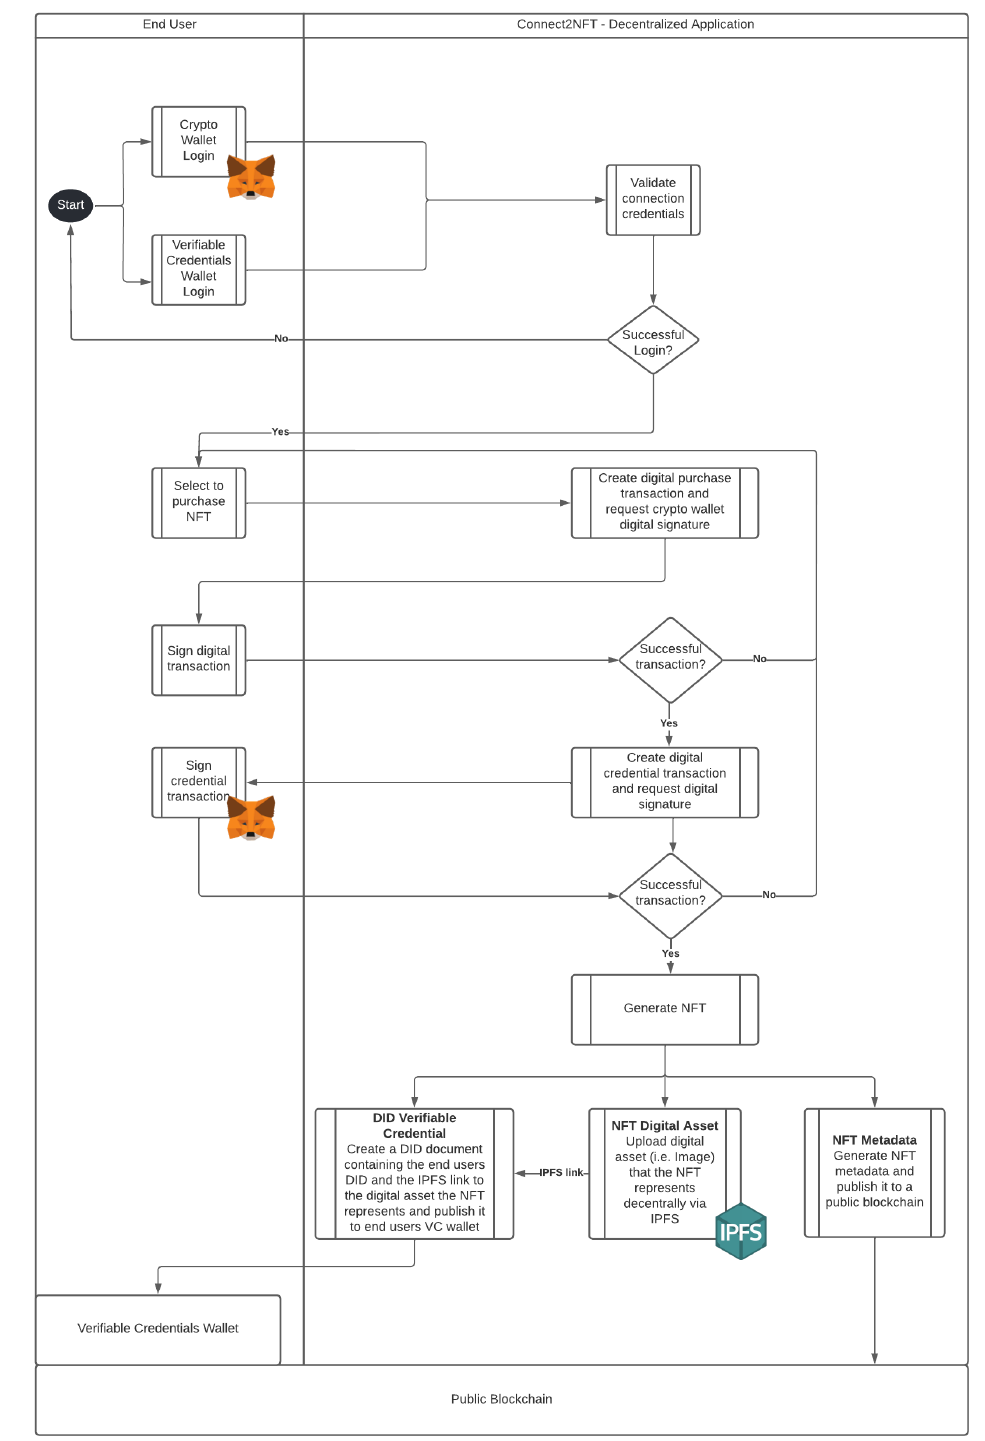
Figure 8. NFT issuing